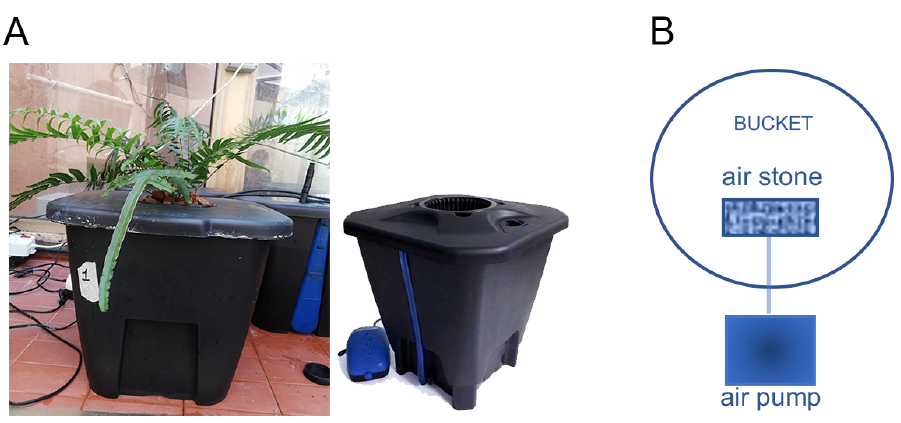
Figure 2. Deep Water Culture (DWC) system. ( A ) a single bucket with an independent oxygenation. ( B ) Functionl Scheme of the DWC.